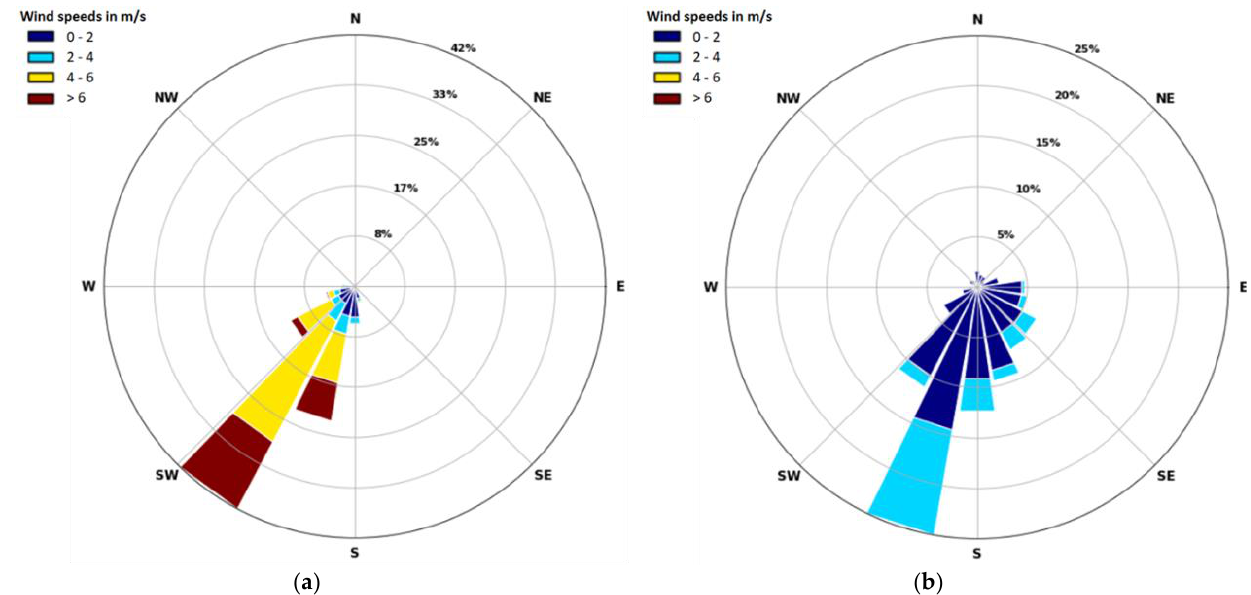
Figure 10. Wind rose graphs showing wind speed and wind direction measured with the TriSonica